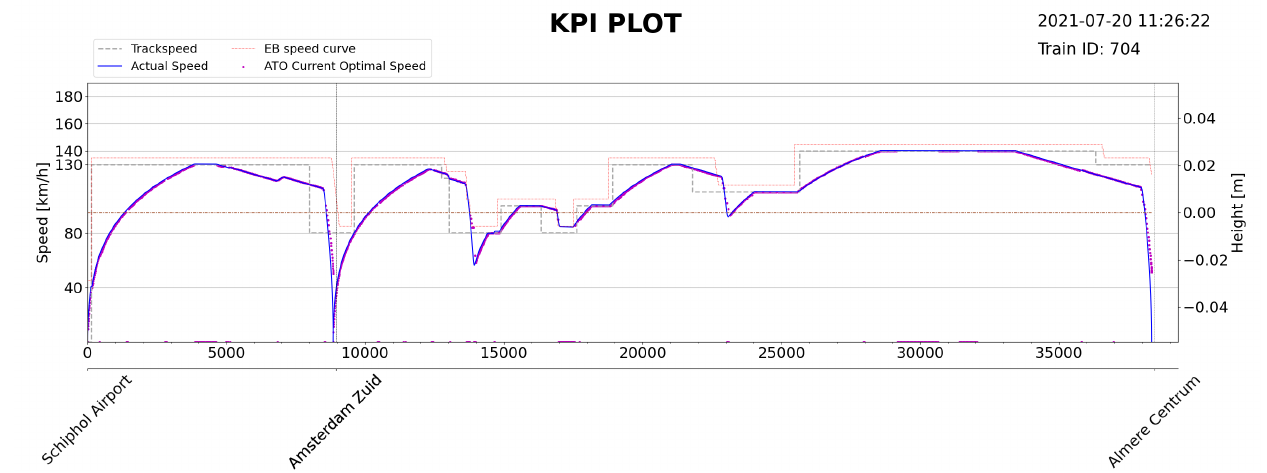
Figure 6. Additional plots generated by the evaluation tool for the original base scenario simulation of logical scenario